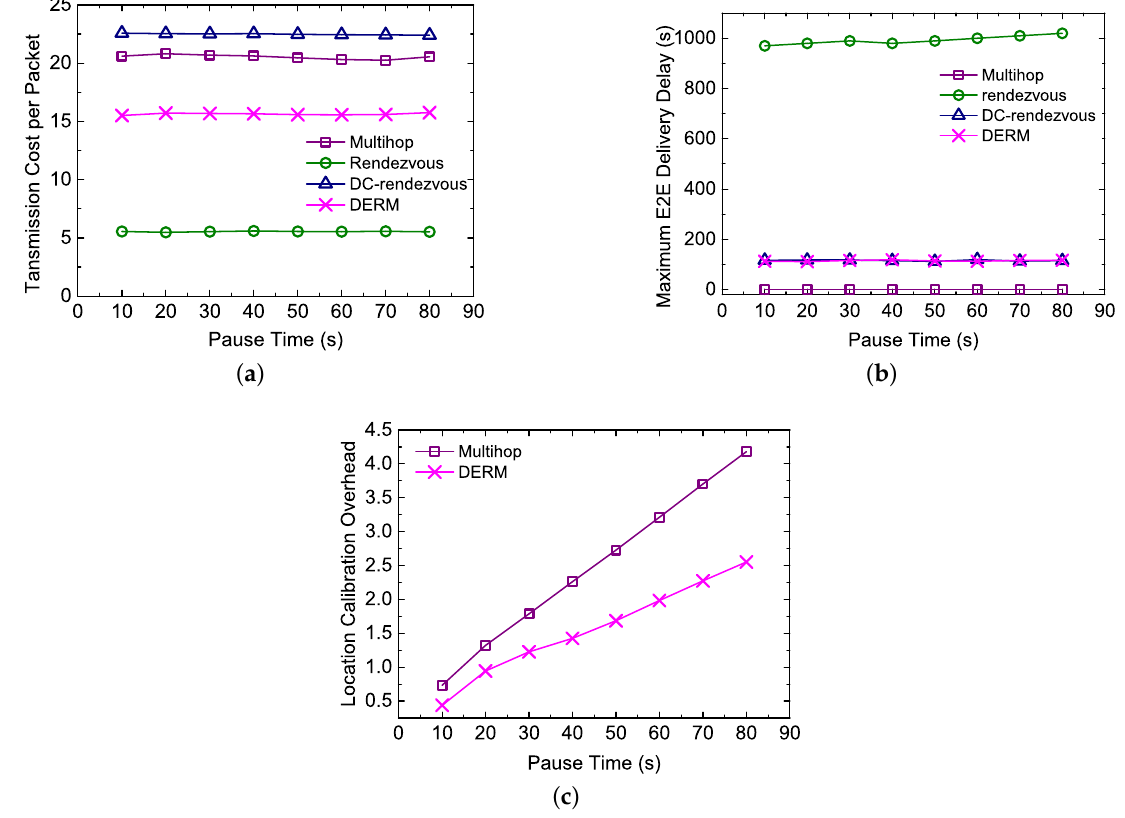
Figure 12. Impact of the pause time ( v M = 2 m/s, D s = 120 s, and α = 1.2). ( a ) transmission cost per packet; ( b ) maximum end-to-end delivery delay; ( c ) location calibration overhead.